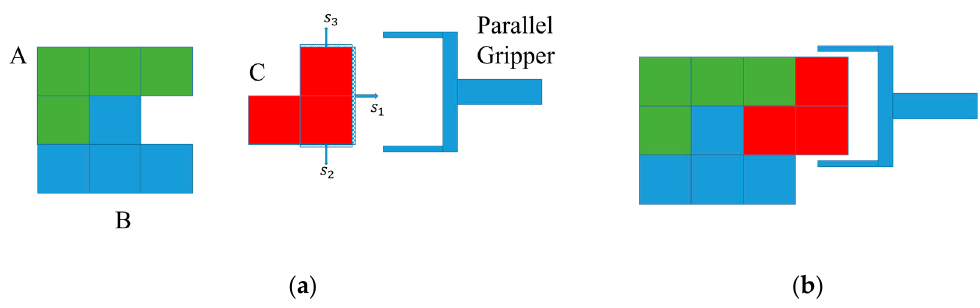
Figure 8. The idea of the feasible grasp using parallel gripper is presented using 2D example. ( a ) Part A (Green), and part B (Blue) are already assembled and part C (Red) is to be assembled. Part C contains three surfaces s 1 , s 2 , and s 3 which define a feasible grasp for parallel grasping as defined in Section 3.1. The surfaces for feasible grasp are exposed in initial pose (in ( a )) as well as final pose (in ( b )) pose of the part C. Table 1. DH parameters of UR5e robot manipulator.